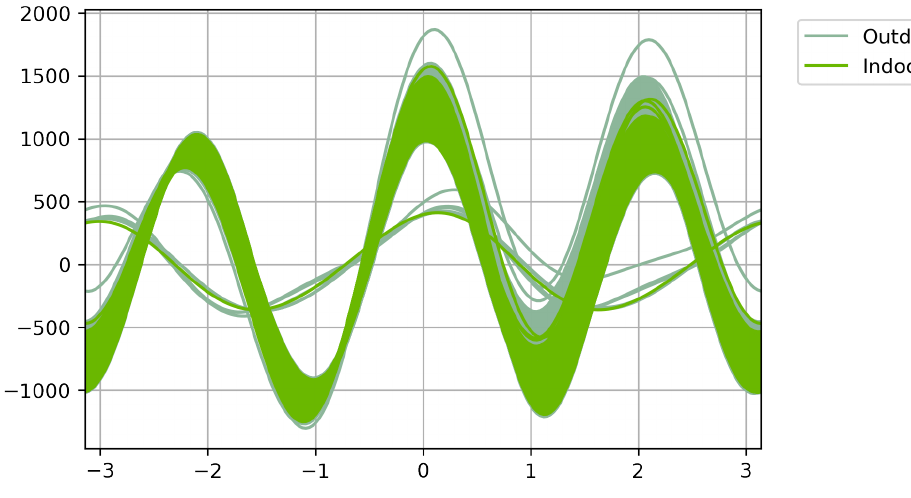
Figure 4. Andrews plot for indoor and outdoor